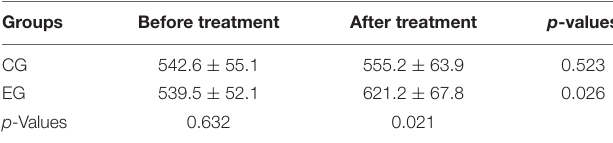
TABLE 5 | The comparison of serum levels of inflammatory cytokines before and after treatment.